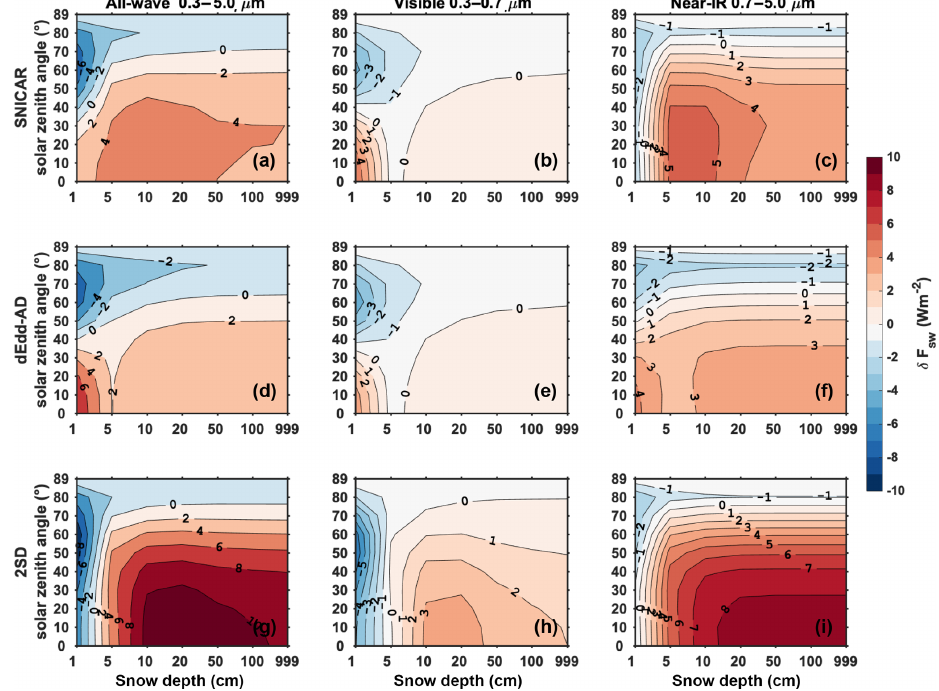
Figure 8. Error in reflected direct solar flux given albedo errors shown in Fig. 4.